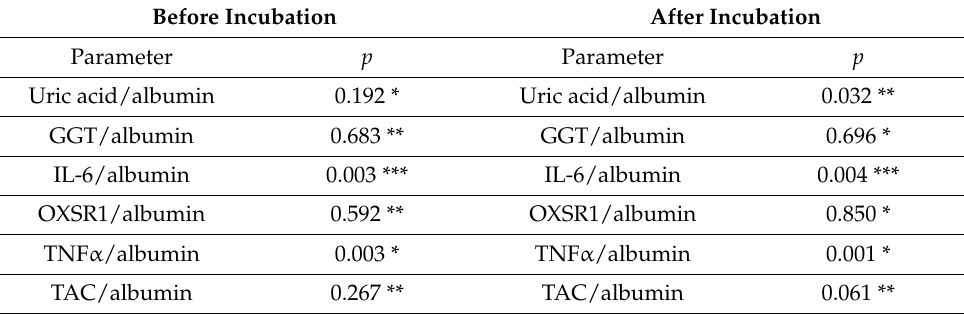
Table 2. Comparison of biochemical parameters between material